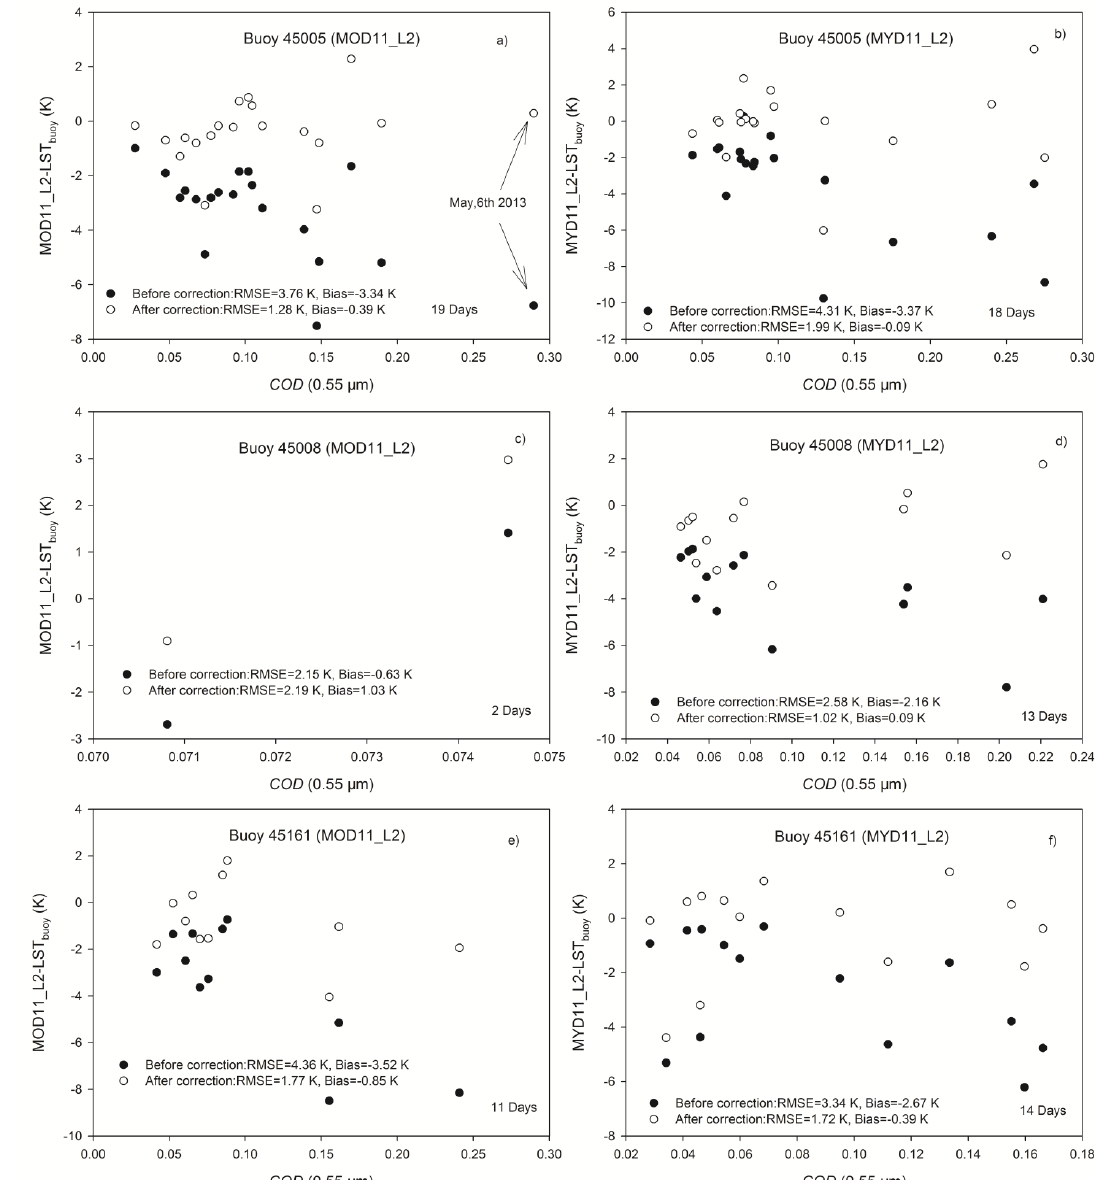
Figure 8. LST differences between LSTs extracted from MOD11_L2/MYD11_L2 and LST buoy (solid circles) and between the LST AC and LST buoy (hollow circles) versus COD (at 0.55 μm) for three different buoys from May to November 2013. ( a , b ) show the result